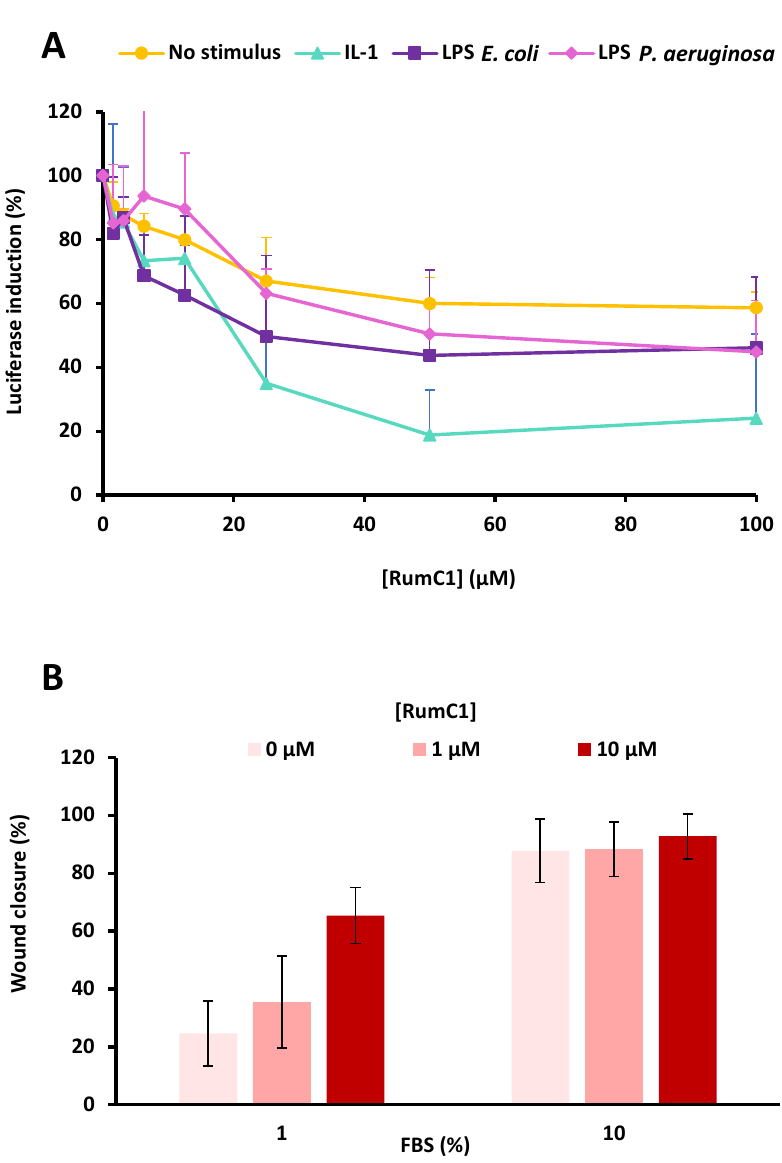
Figure 5. Host beneficial activities of RumC1. ( A ) Evaluation of the anti-inflammatory effect of RumC1. HeLa eLUCidate TLR4/IL-8 cells were incubated with IL-1 β , LPS from E. coli or P. aeruginosa , or without any pro-inflammatory stimulus, and then treated with increasing concentrations of RumC1. Luciferase luminescence, induced by pro-inflammatory transcription factors, was measured. Results are expressed as the percentage of maximum response measured without RumC1. ( B ) Percentage of gap closure during a wound healing assay on HaCaT (human keratinocytes cells) cells in the absence or the presence of RumC1. Percentages of closure were measured four days after the gap formation and treatment. FBS (fetal bovine serum) at 10% was used as a positive control. All experiments were performed in independent triplicates.